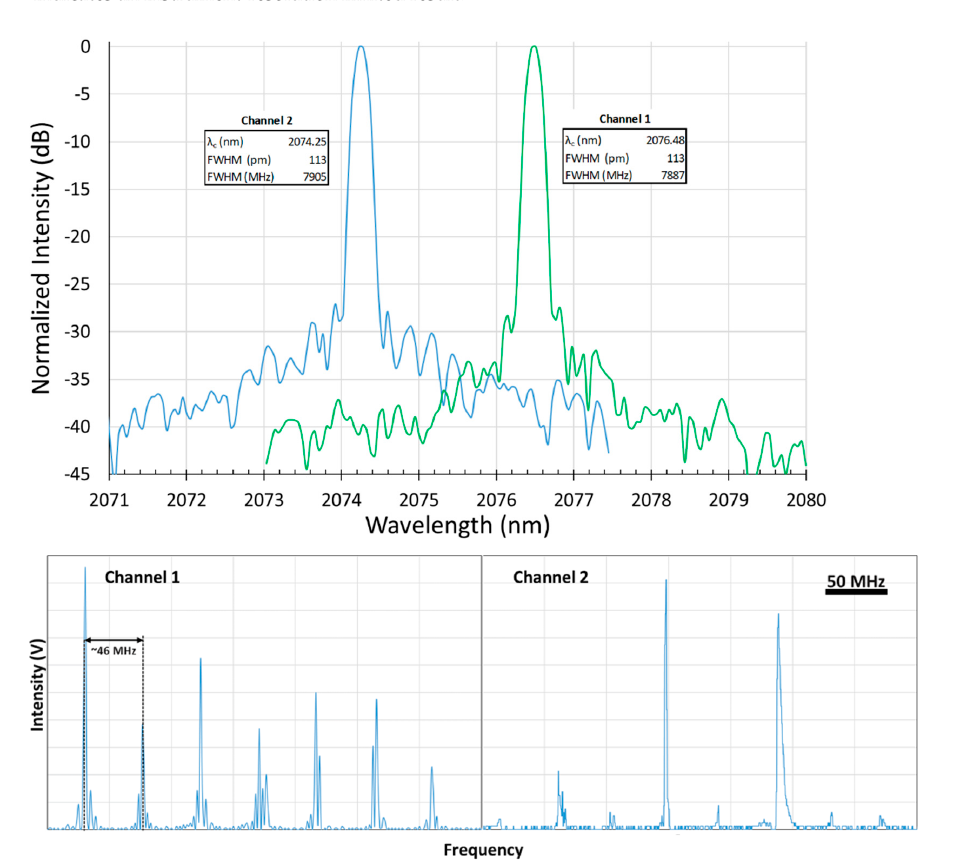
Figure 4. ( top ) Spectral line shapes of Channel 2 (blue) and Channel 1 (green) as observed at their fiber-side outputs, each normalized to 0 dB. The line widths are instrument resolution limited. ( bottom ) Single scan of a 1.5 GHz FSR Fabry-P é rot Interferometer of the fiber-side outputs. 50 MHz scale bar for the x -axis is shown and observed detector voltage ( y -axis) is scaled for best visibility. Observed mode spacing is ~46 MHz ± 3 MHz, with variations owing to cavity fluctuations occurring over measurement timeframes.